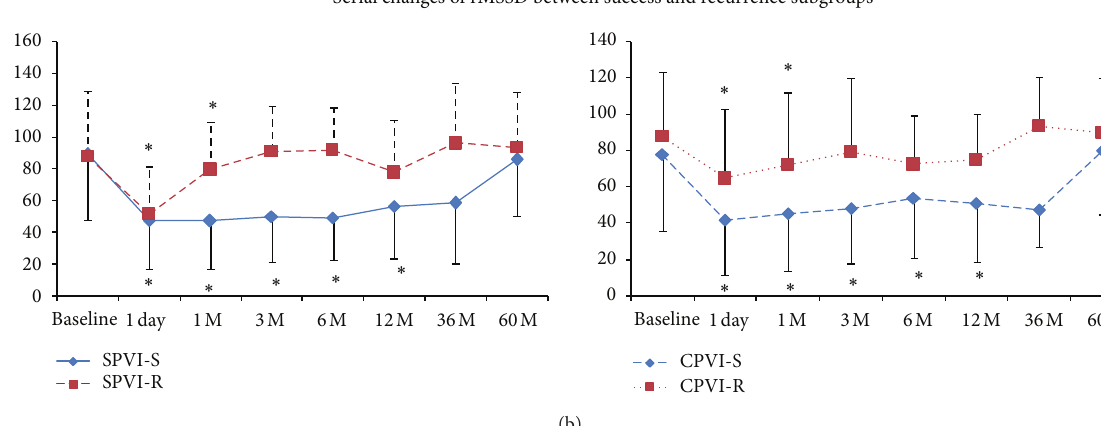
Figure 4: Serial changes of SDNN and rMSSD during five-year follow-up. (a) SDNN remained attenuated during 12-month follow-up in SPVI-S and CPVI-S subgroups, while recovered after 6 months in SPVI-R and CPVI-R subgroups. (b) rMSSD remained attenuated during 12-month follow-up in SPVI-S and CPVI-S subgroups, while recovered after 1 month in SPVI-R and CPVI-R subgroups. ∗ 𝑃 < 0.05 .